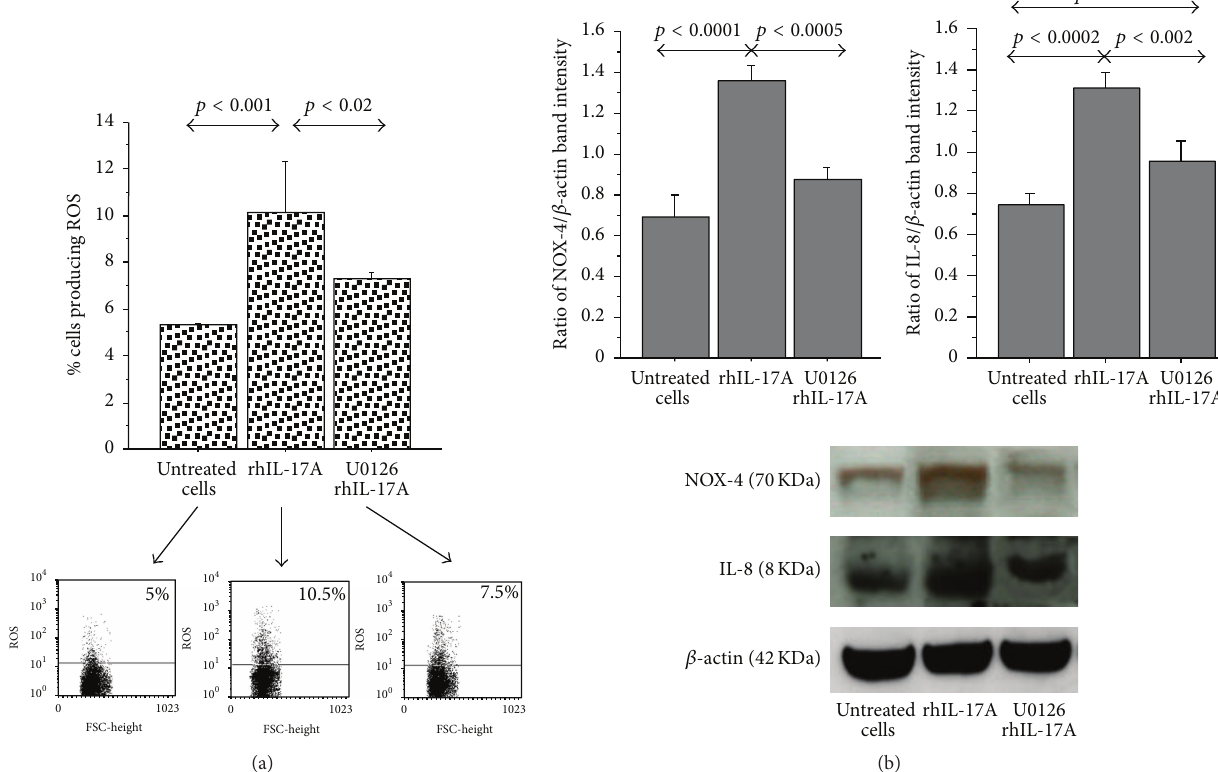
Figure 2: Effect of U0126 inhibitor in RPMI 2650 cells stimulated with rhIL-17A. (a) The cells were stimulated with rhIL-17A (20 ng/mL) for 6 hrs in absence or presence of U0126 (25 𝜇 M). ROS production was evaluated in the cells by flow cytometry. The bars represent the mean ± SD of 3 separate experiments. Representative flow cytometry are shown; (b) the cells were stimulated with rhIL-17A (20 ng/mL) for 18hrs in absence or presence of U0126 (25 𝜇 M). NOX-4 and IL-8 protein expression were evaluated in the cell lysates by western blot. The results were expressed as ratio of band intensity and 𝛽 -actin of 3 separate experiments. Representative western blot is shown. ANOVA with Fisher’s test correction was used for the analysis of the data. 𝑝 < 0.05 was statistically